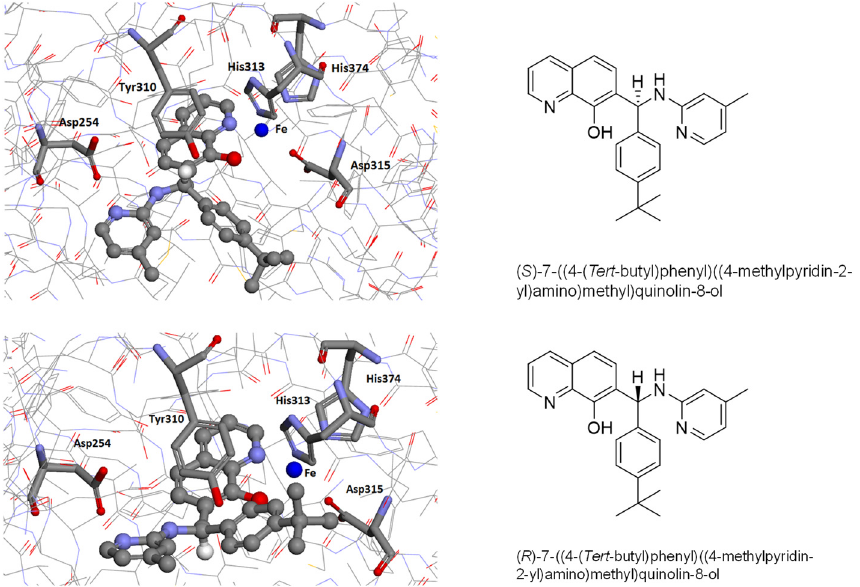
Figure 4. Docking of neuradapt enantiomers into HIF PHD2 crystal structure (PDB: 2G19). Asp254 interacts with the pyridine nitrogen, and Tyr 310 restricts rotation of pyridine and phenyl rings in the “branched-tail”(see Table S1 in Supplement for docking energy values).